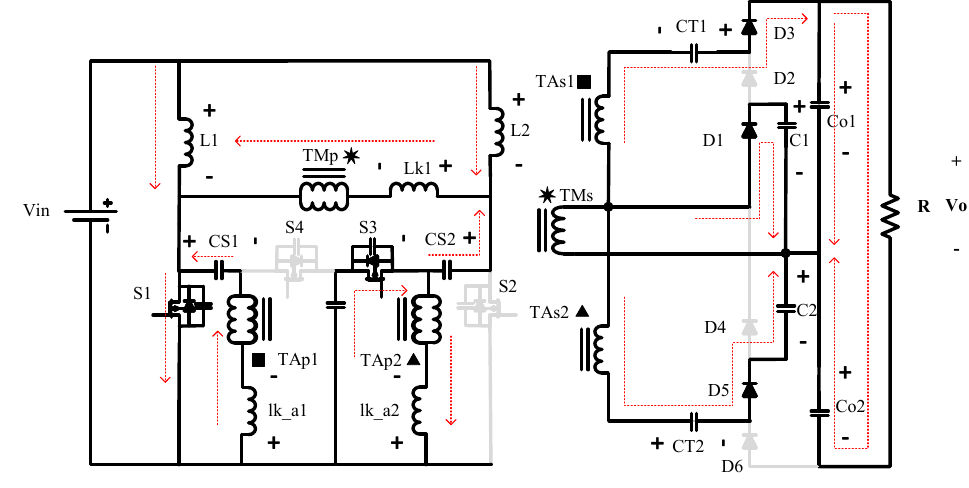
Figure 3. First switching state.